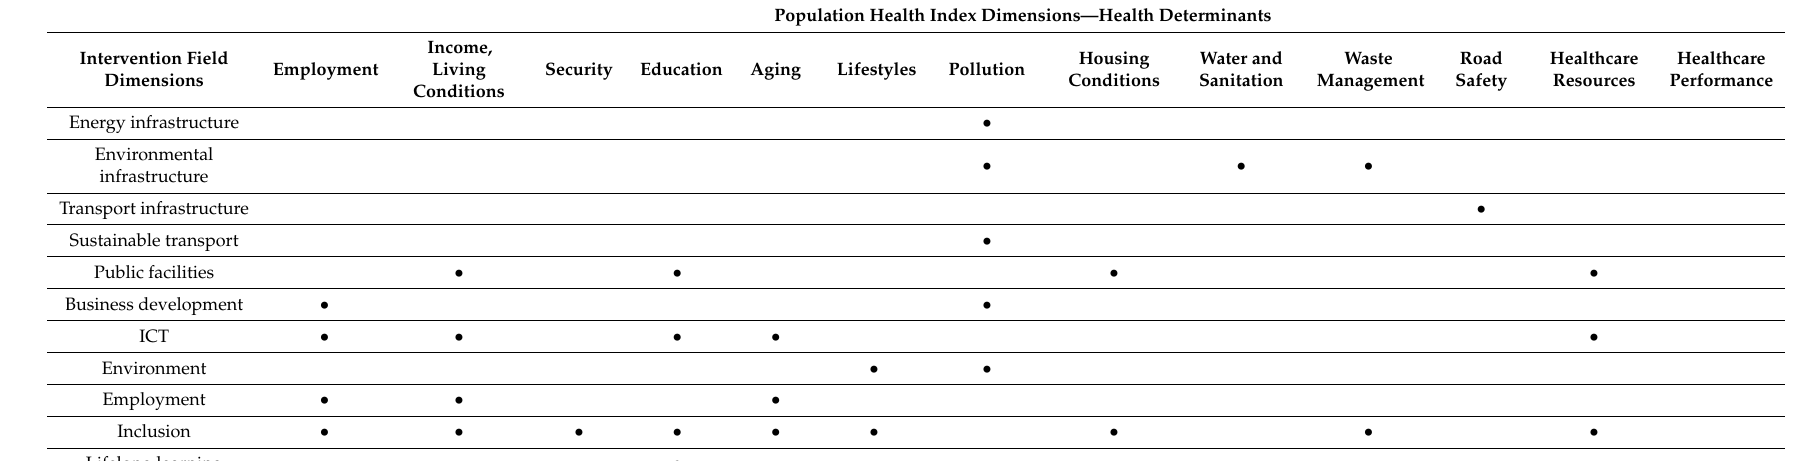
Table 4. Matrix of Cohesion Policy intervention field dimensions and the EURO-HEALTHY population health index